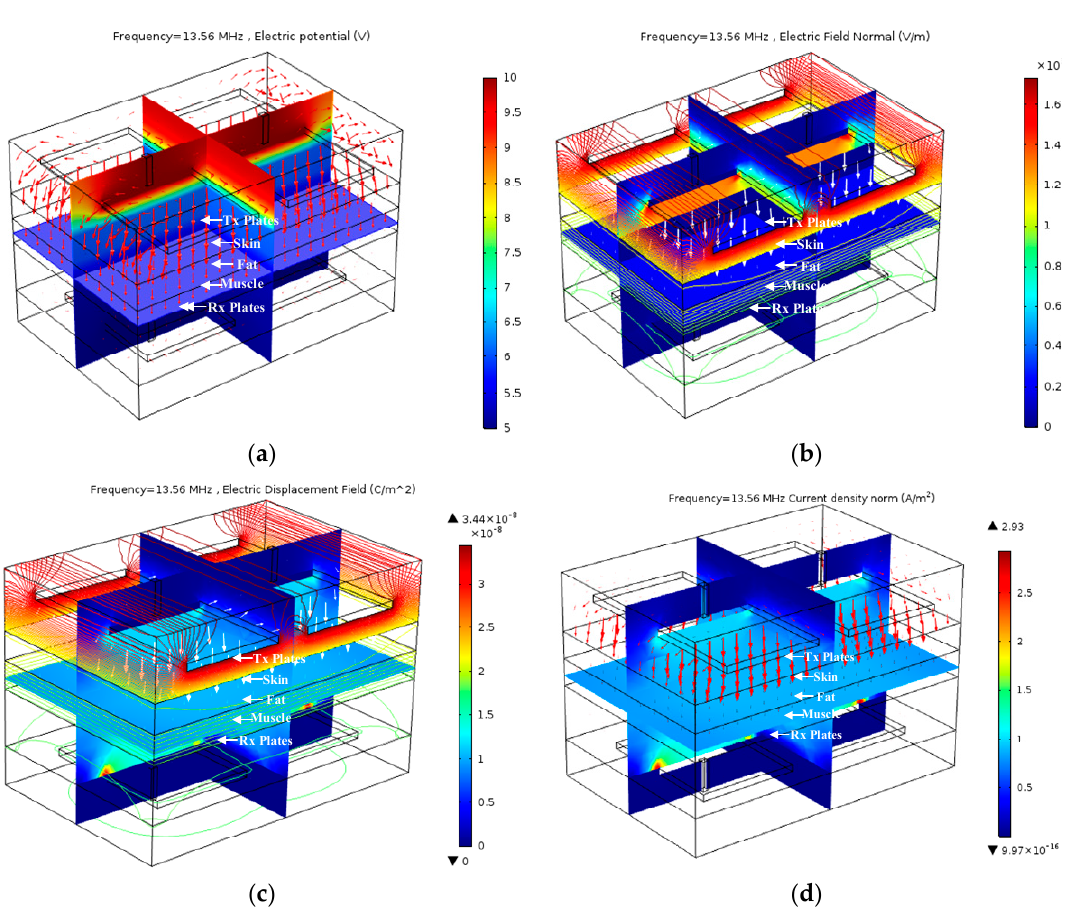
plates under skin.